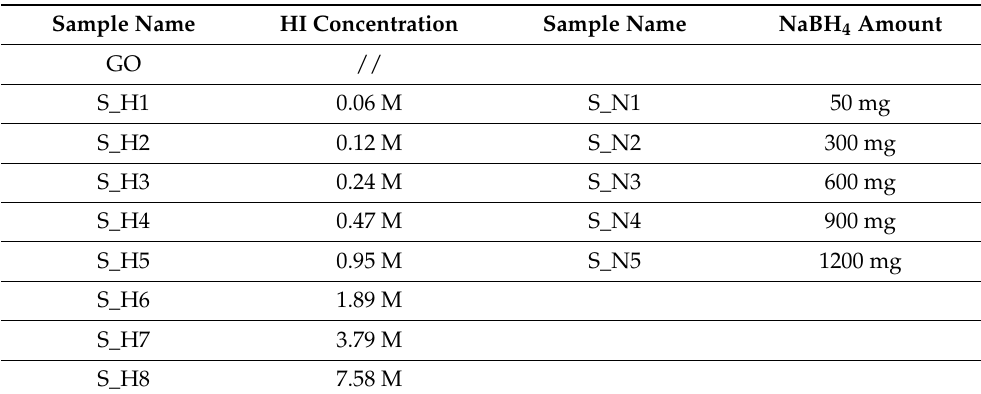
Table 1. Summary of the rGO produced using HI and NaBH 4 . The correspondent reductant concen- trations are indicated.